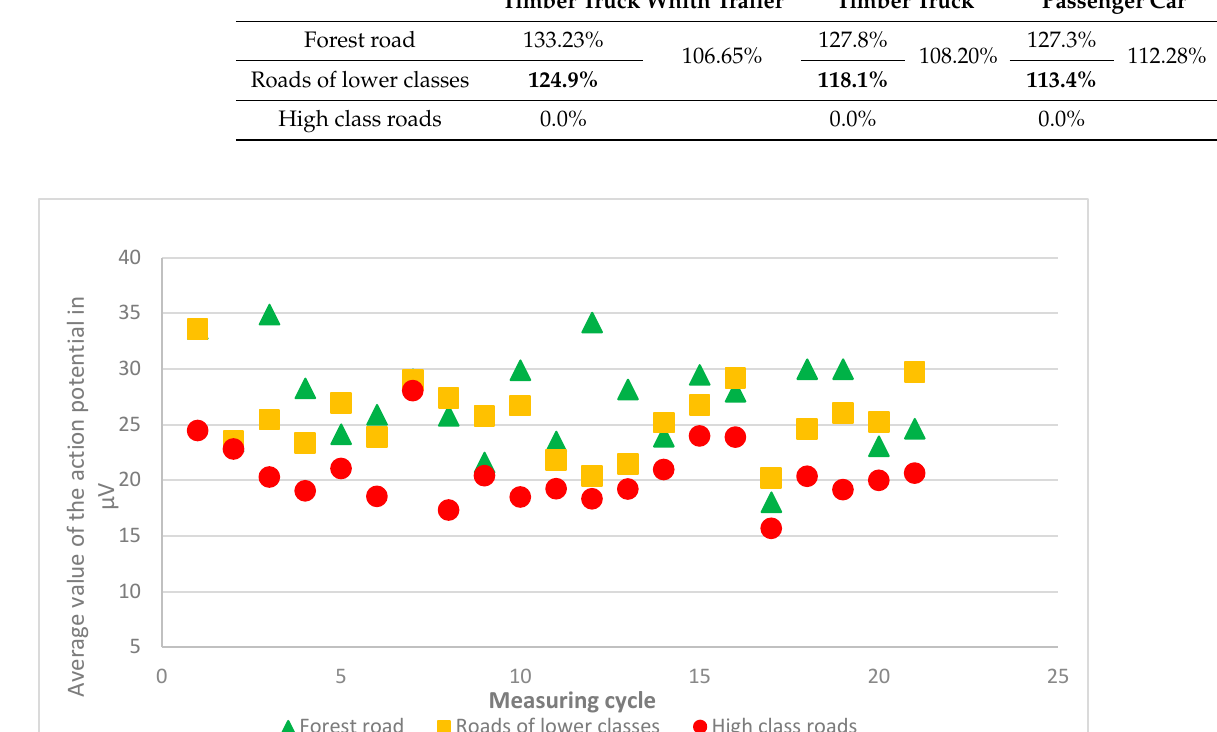
Figure 2. Comparison of the course of changes in muscle load expressed in μ V of electric potential on monitored types of roads when driving a timber truck with trailer (author).